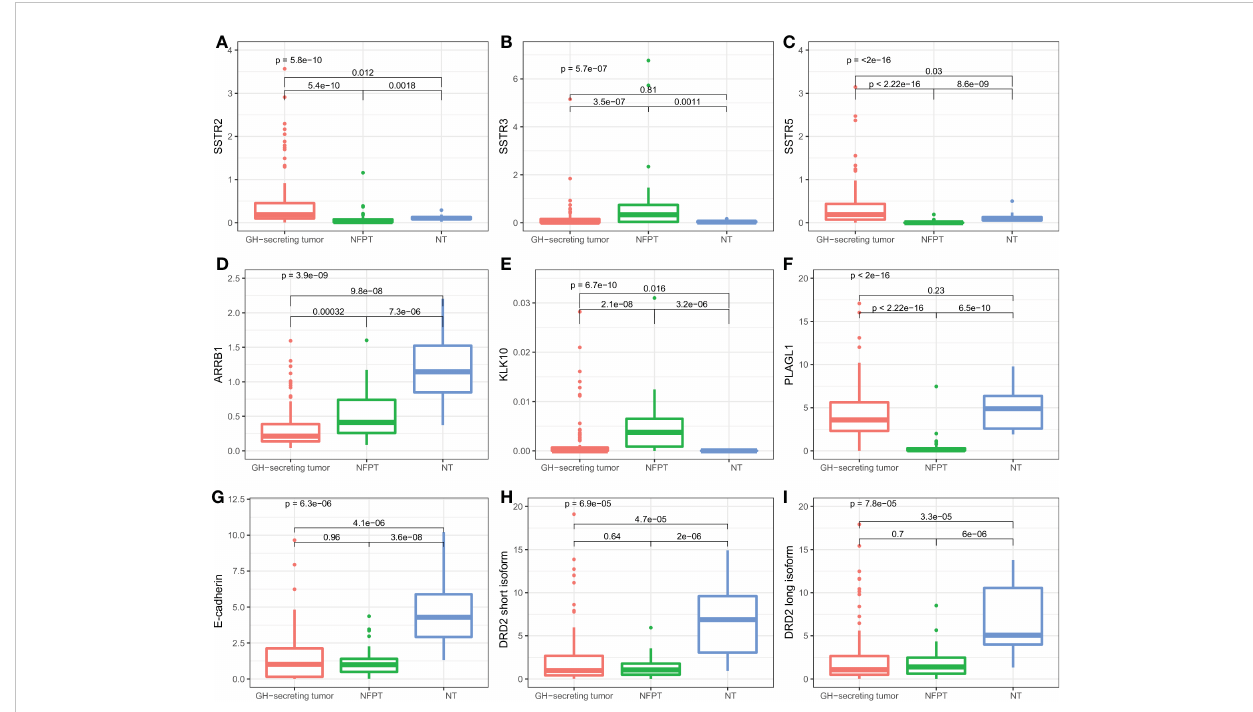
ability of these markers in predicting recurrence in NF-PitNETs (Table 4), and found that only PEBP1 showed a difference between tumors that recurred and tumors that did not (p=0.036) (Figure 3A). When performing a binomial logistic regression, PEBP1 showed an AUC of 69.9%, for a cut-off of 14.0, with a sensitivity of 100% and a speci fi city of 42.6% (Figure 3B).